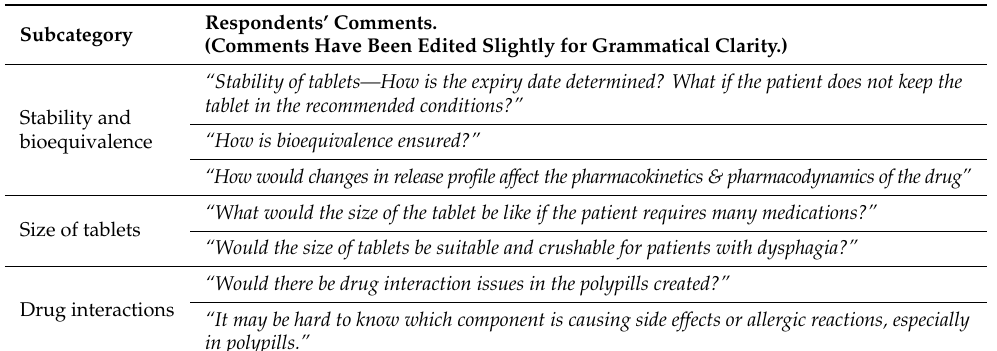
Table 1. Concerns raised by healthcare professionals regarding the 3D printed tablets. Respondents’ Comments. Subcategory (Comments Have Been Edited Slightly for Grammatical